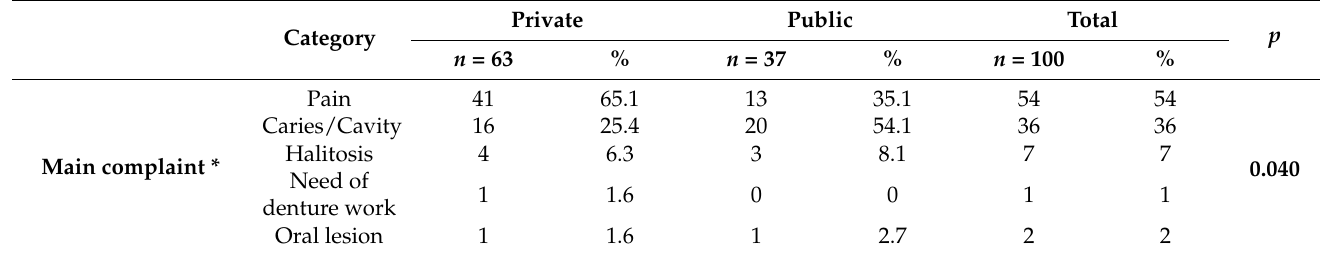
Table 5. Sample distribution based on main dental problems and complaints.